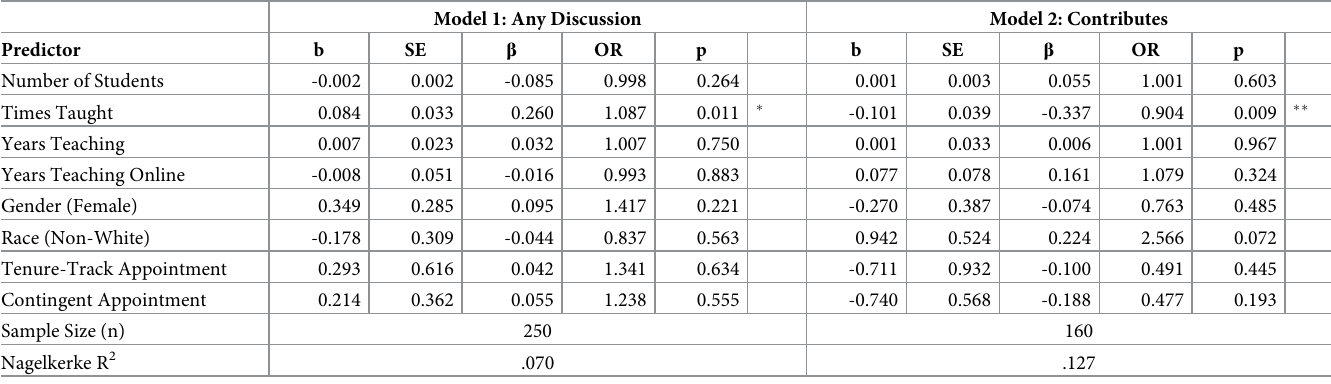
Table 5. Logistic regression predicting discussions and contributions.